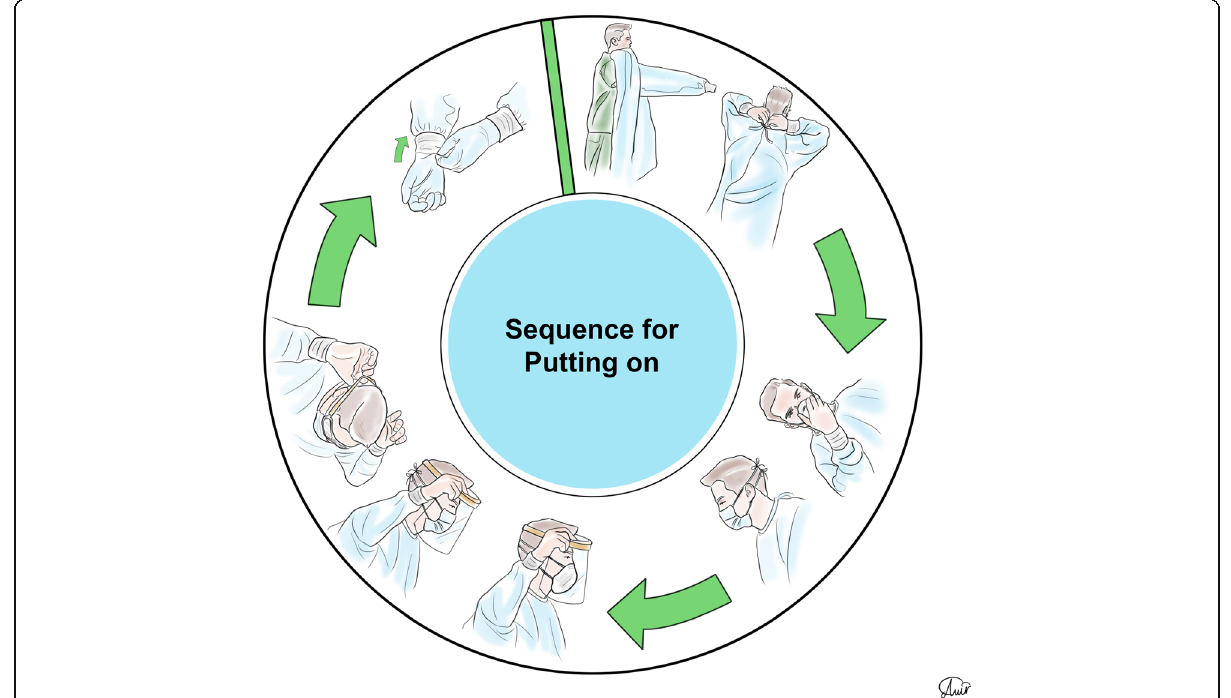
Fig. 2 Personal protection equipment donning